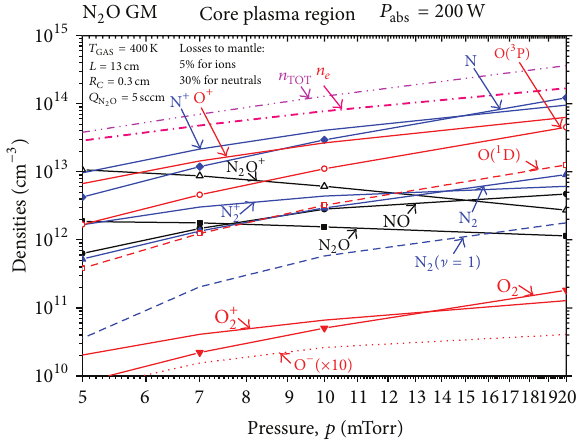
Losses to mantle: 5 % for ions 30 % for neutrals